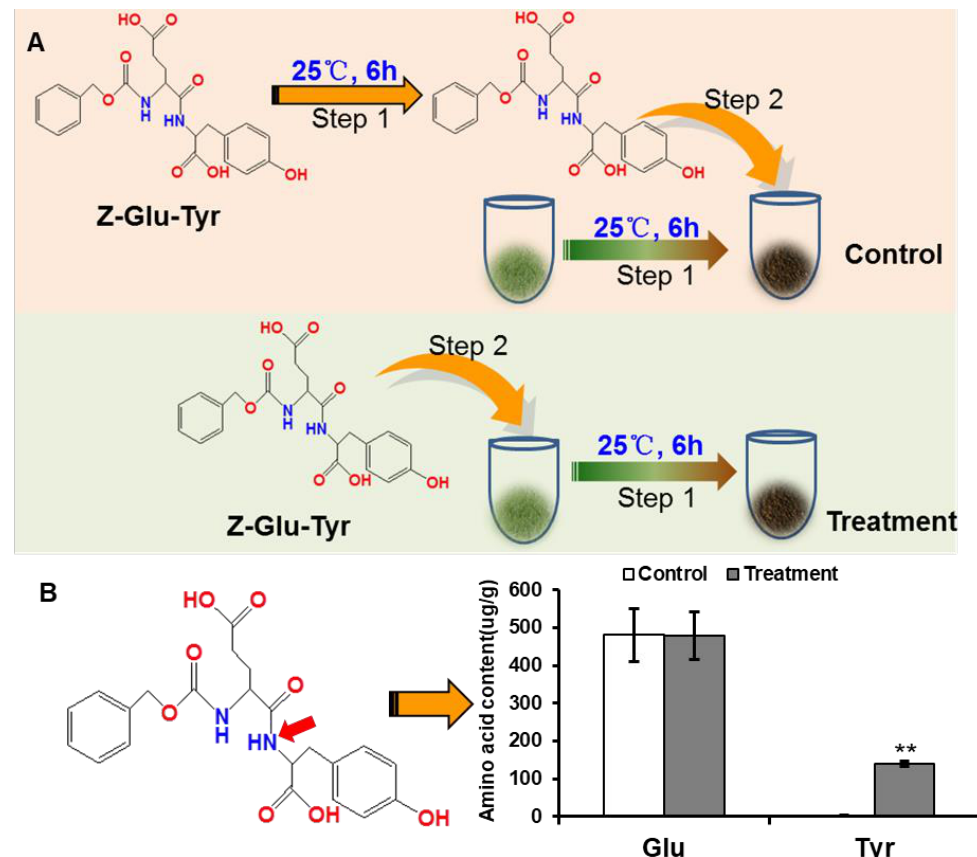
Figure 2. Identification of protein degradation during black tea fermentation with an artificially synthesized dipeptide benzyloxycarbonyl glutamyl-tyrosin (Z-Glu-Tyr). ( A ) Schematic diagram of experimental design. Control: Z-Glu-Tyr and tea leaves powder were fermentation respectively at 25 °C for 6 h, and then mixed to detect the contents of free Glu and Tyr. Treatment: Z-Glu-Tyr and tea leaves powder were mixed first, and then companied fermentation at 25 °C for 6 h step 1, Z-Glu-Tyr and tea leaves powder were fermentation at 25 °C for 6 h respectively (control) or mixed (treatment); step 2, Z-Glu-Tyr mixed with tea leaves powder. ( B ) Changes of Glu and Tyr content after enzymatic reaction during the fermentation. Data shown as the mean ±SD ( n = 3). ** p < 0.01 vs. Control.